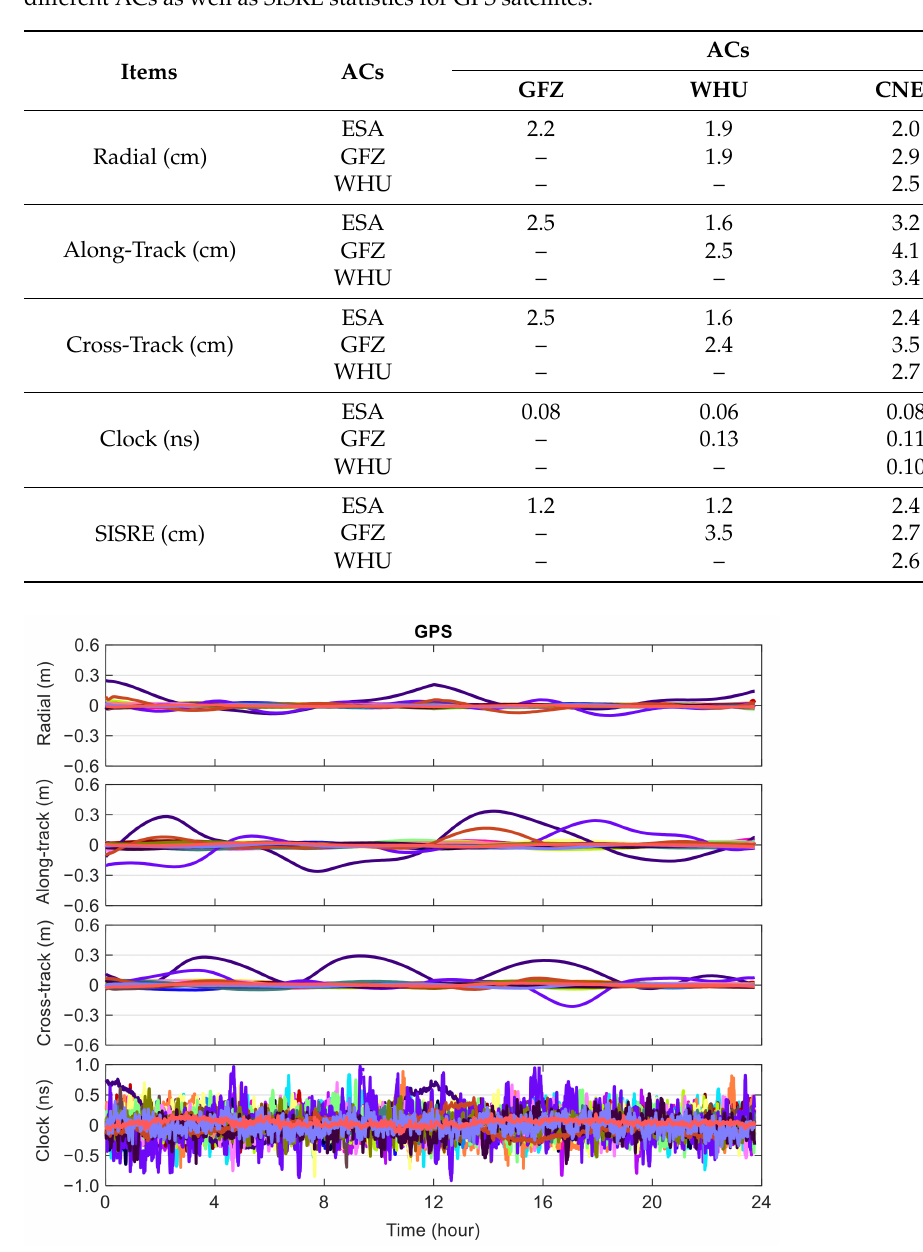
Figure 3. Epoch-wise orbit and clock differences for GPS satellites between GFZ and WHU precise products on DOY 122 of